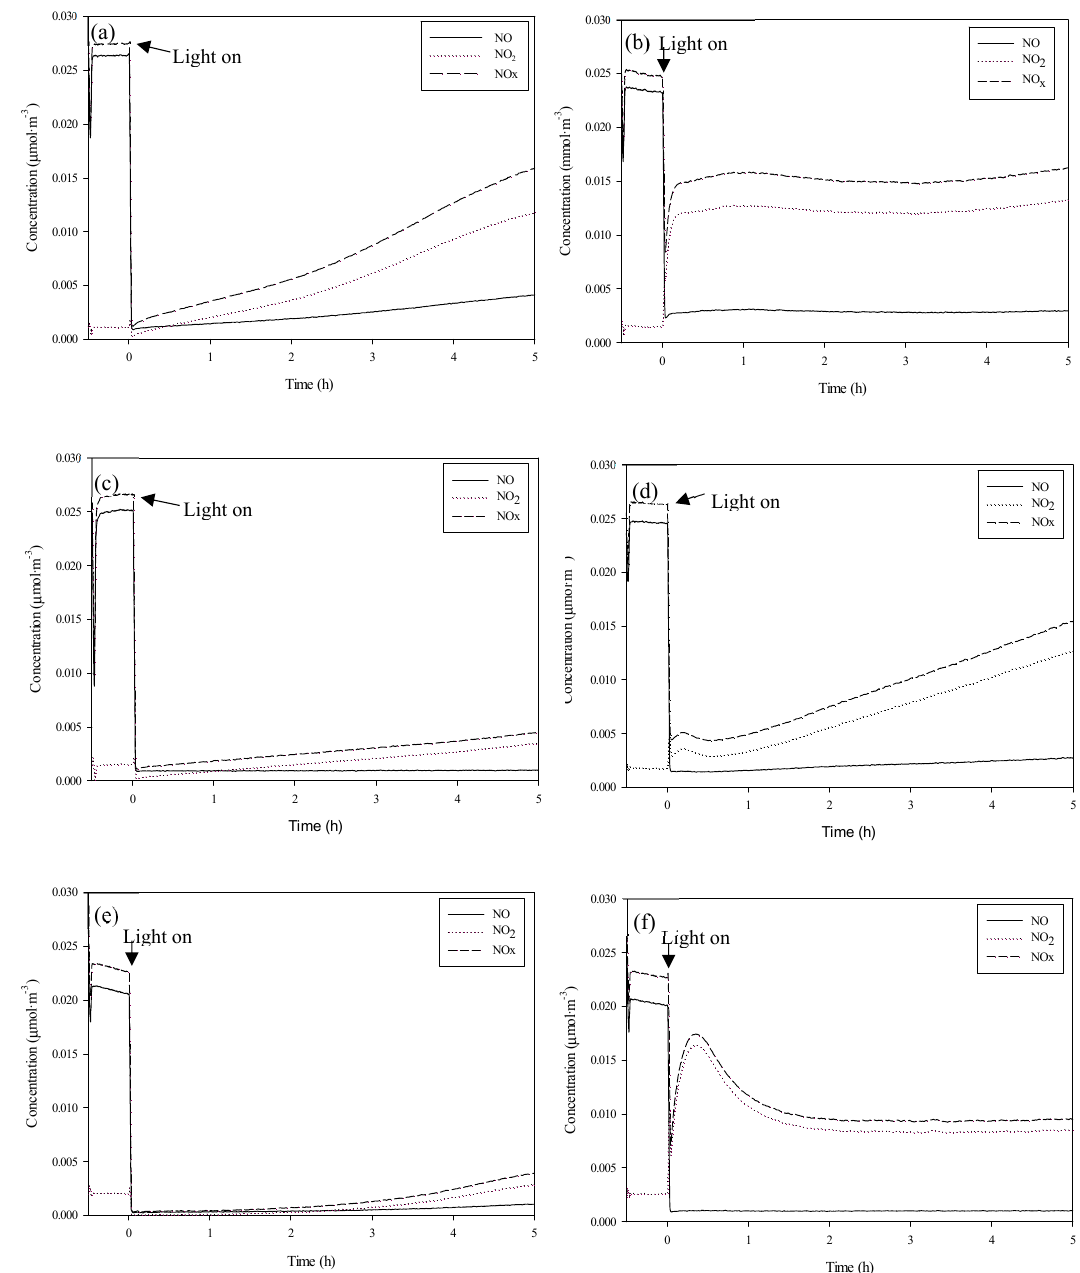
Figure 6. Evolution of species for P25 0% RH ( a ), P25 65% RH ( b ), Pd-P 0% RH ( c ), Pd-P 65% RH ( d ), Pd-I 0% RH ( e ) and Pd-I 65% RH ( f ).